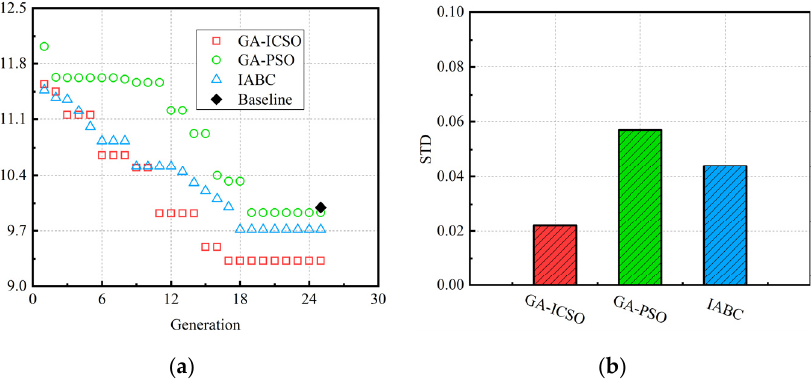
Figure 15. Optimization history of GA-ICSO, GA-PSO and IABC for 100% load: ( a ) Objective function convergence; ( b ) STD.